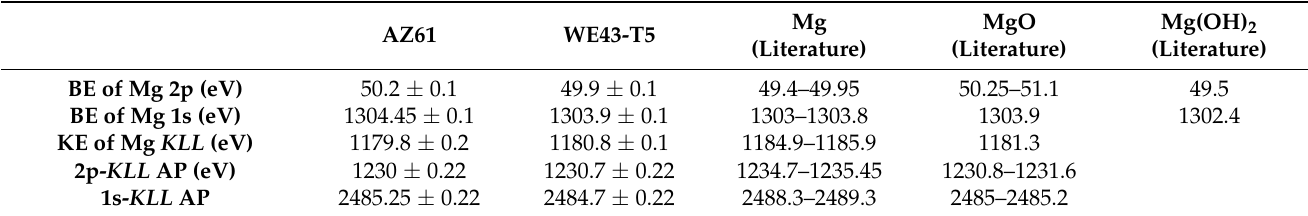
Table 5. Mg 2p-KLL and Mg 1s-KLL final state Auger parameters in corroded